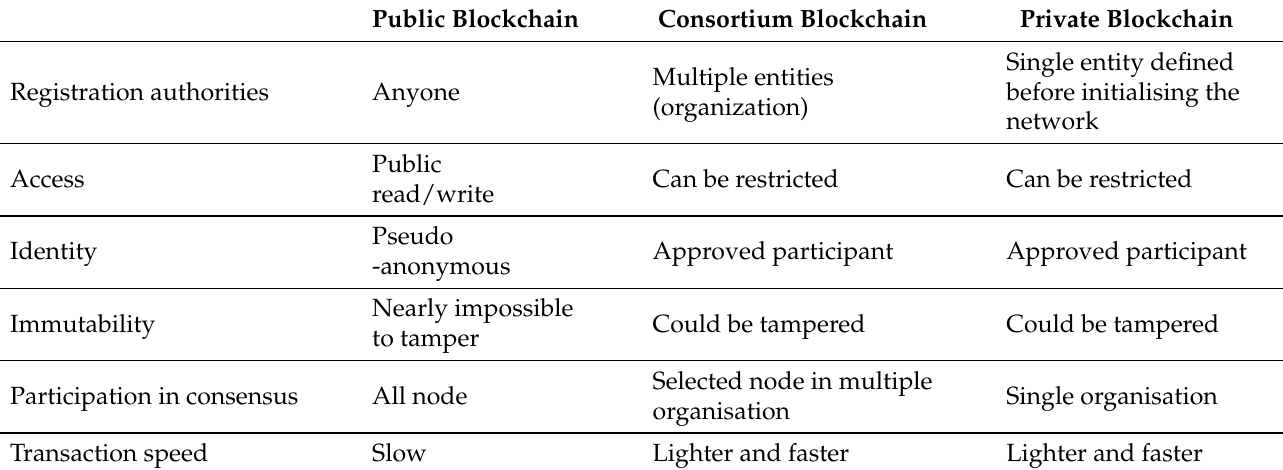
Table 1. Types of blockchains